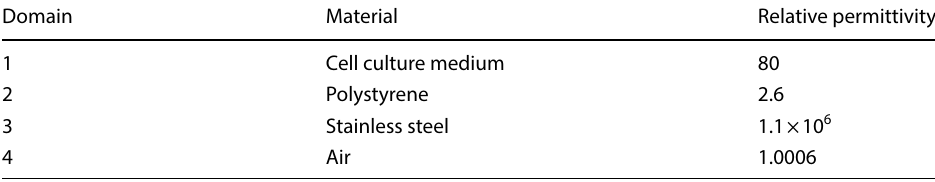
Table 1 Electrical properties of modeled